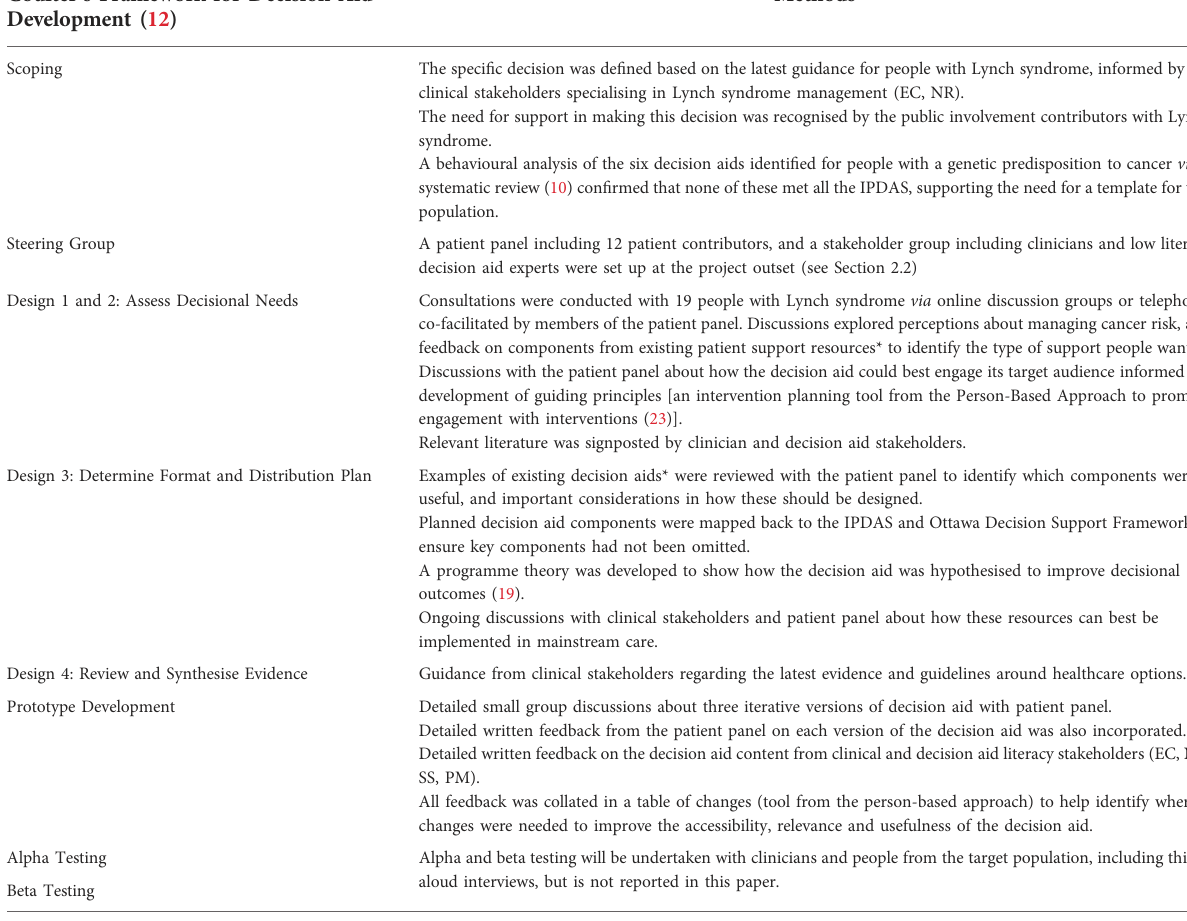
TABLE 2 Co-development process based on coulter ’ s framework for decision aid